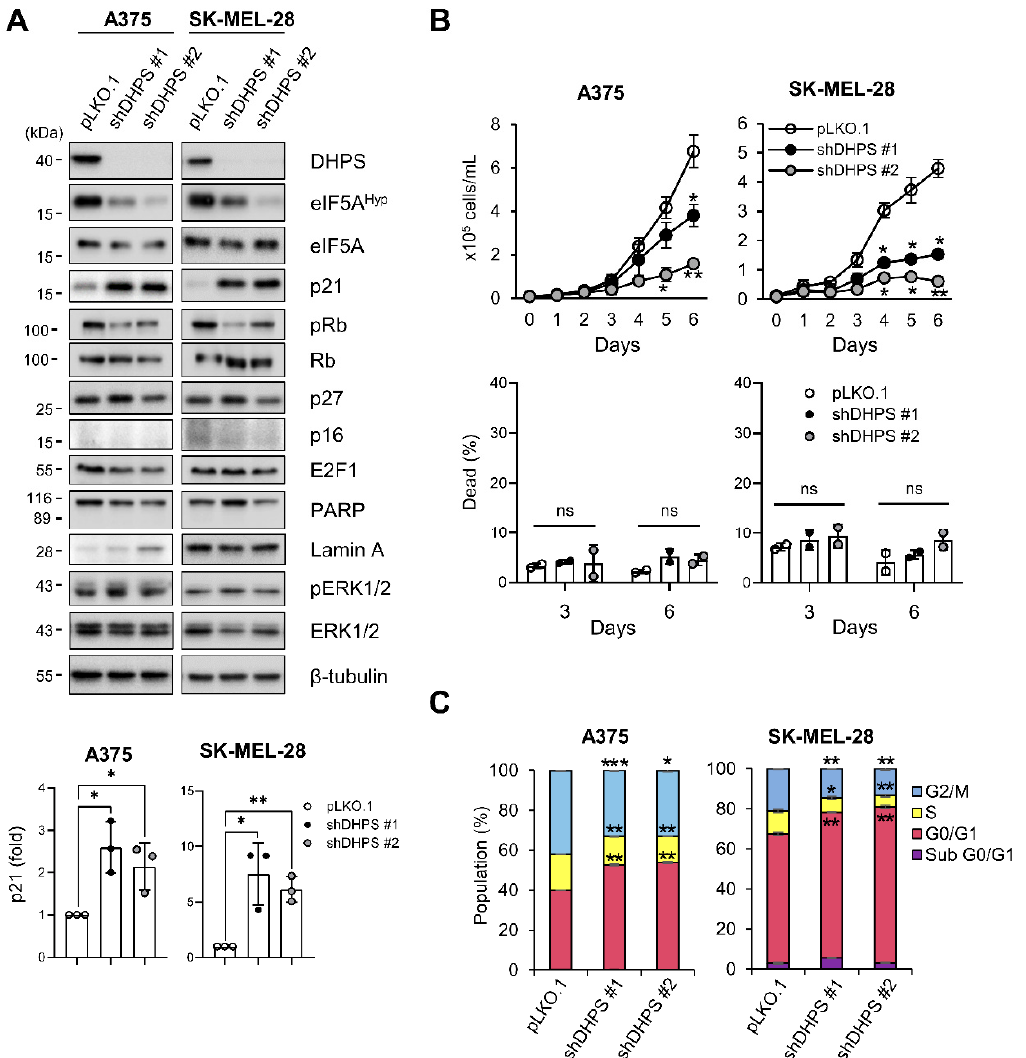
Figure 1. DHPS knockdown increases p21 CIP1 levels and induces growth arrest without causing cell death in A375 andSK ‐ MEL ‐ 28 cells. ( A ) Western blots of total lysates of cells infected for 5 days with pLKO.1 viruses expressing shRNA targeting different regions of DHPS mRNA (shDHPS #1 and shDHPS #2). β‐ tubulin is the control for equal protein loading. Empty virus was used as a control. (bottom) Densitometry of p21 CIP1 . ( B ) Time ‐ course trypan blue exclusion assays to determine viability of cells infected as described in ( A ). ( C ) Propidium iodide staining and flowcytometry to determine cell cycle phases of cells treated as described in ( A ). Data are mean ± SD of biological triplicates. * p < 0.05, ** p < 0.005 and *** p < 0.001 by two ‐ tailed Student t ‐ test.